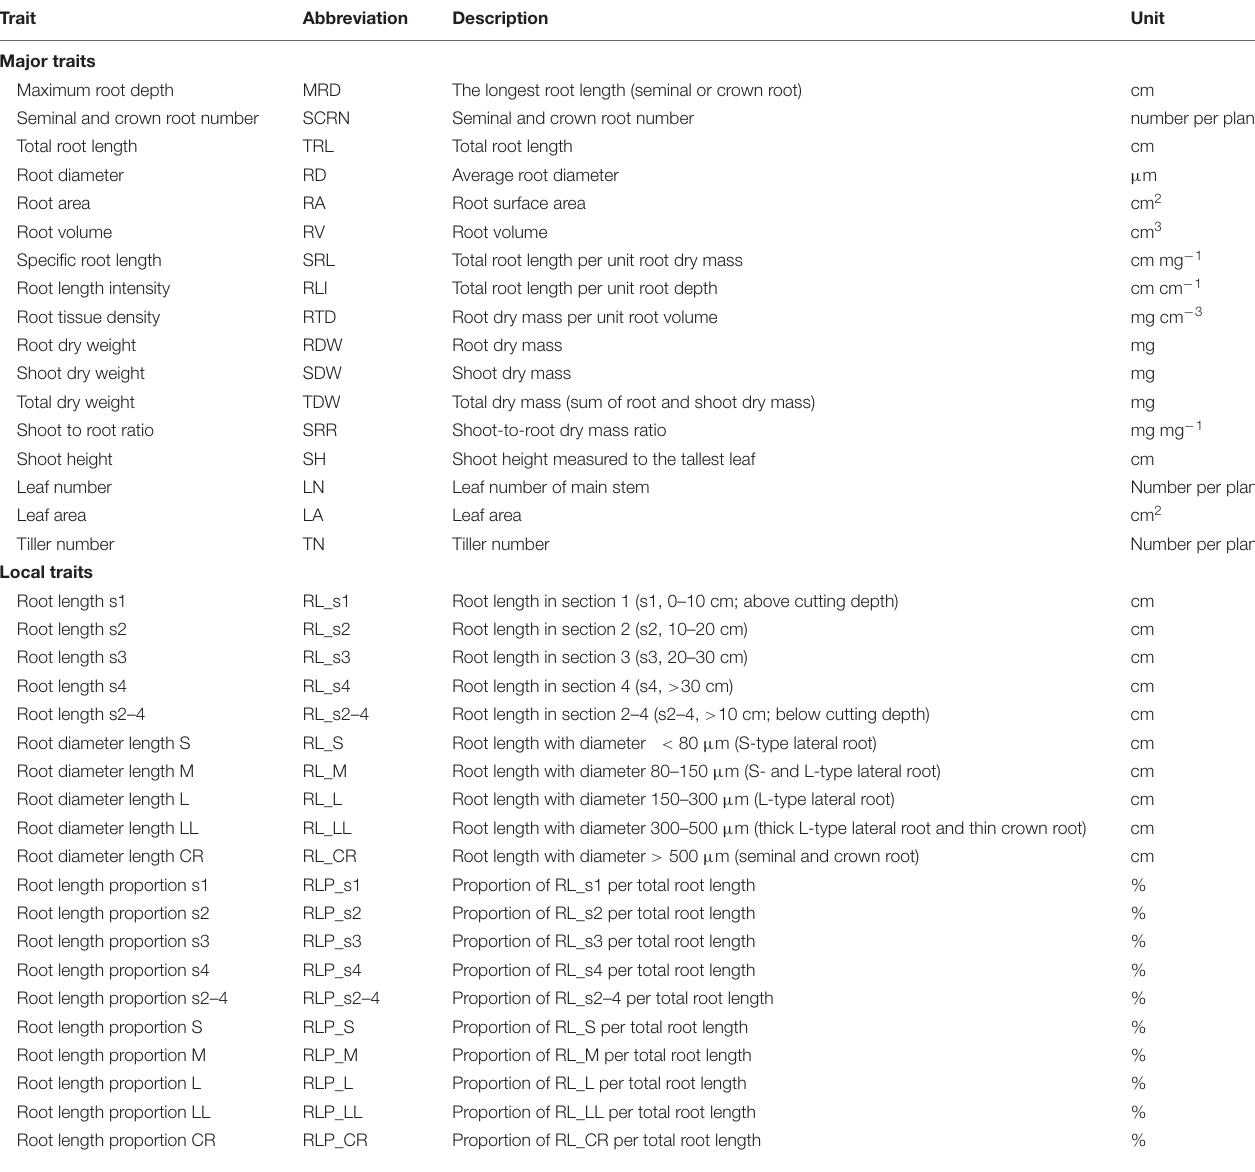
TABLE 2 | Description of 32 root-related traits and five shoot traits in rice characterized in a semihydroponic phenotyping system.